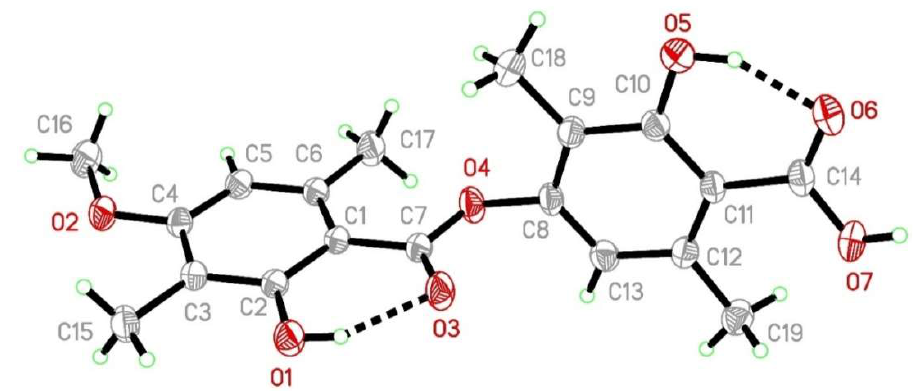
Figure 4. Crystal structure of barbatic acid ( 21 ): the molecular structure of barbatic acid, with the atom-numbering scheme. Displacement ellipsoids are drawn at the 30% probability level and H atoms are shown as small spheres of arbitrary radius. Intramolecular hydrogen bonds are shown as dashed lines.